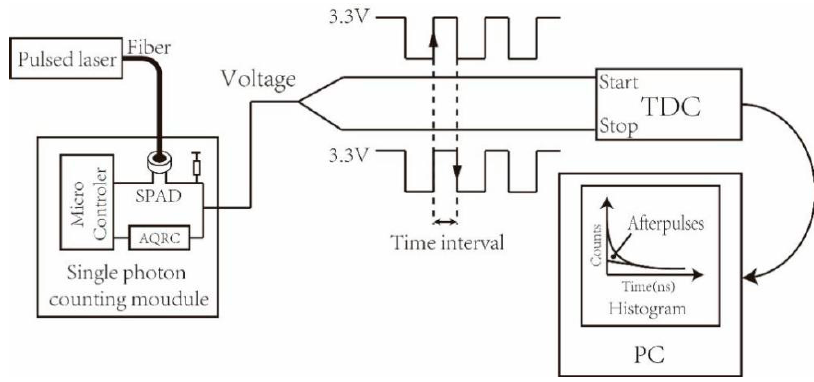
Figure 9. Experimental setup for measuring SPAD’s afterpulsing probability.